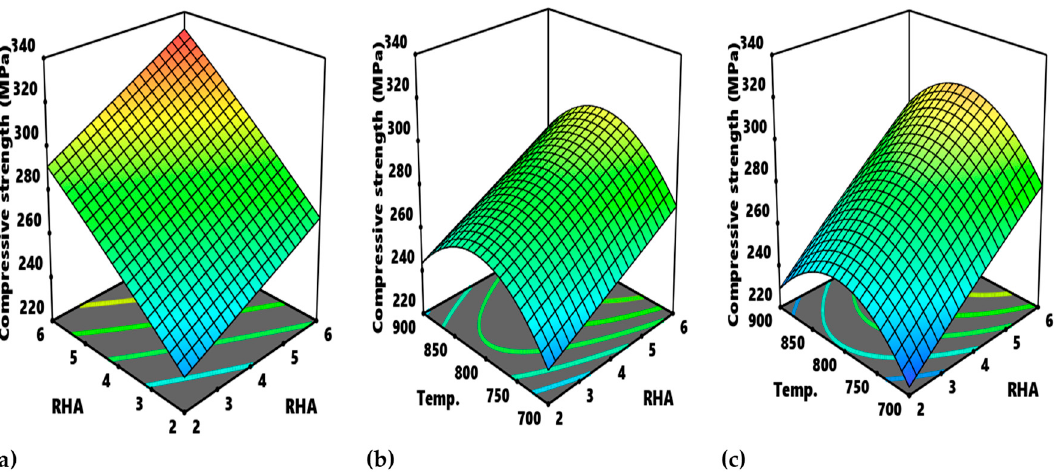
Figure 11. Surface plots representing the relationship of the variables that affect compressive strength as revealed by interactions ( a ) PKA vs. RHA ( b ) PKA vs. stirring temperature ( c ) RHA vs. stirring temperature.